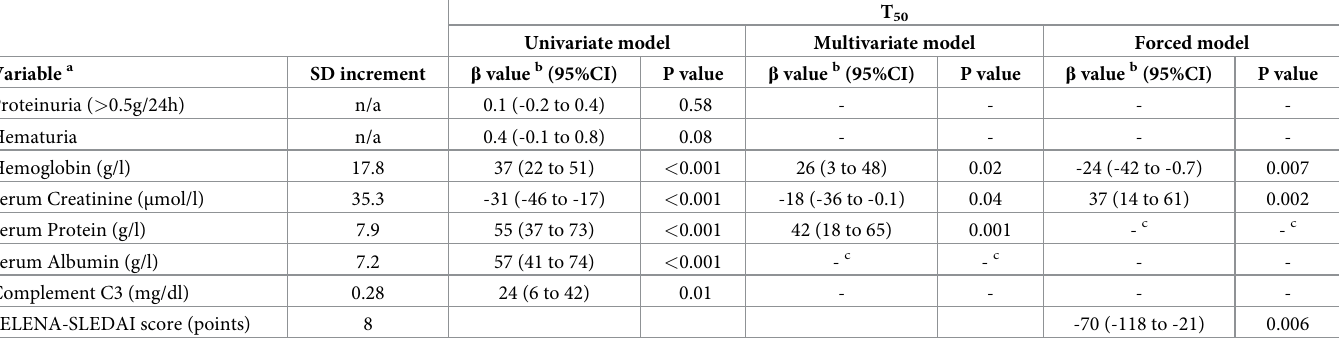
Table 2. Determinants of serum calcium propensity score (T 50 ) in univariate, multivariate linear regression analyses and in forced model using SELENA-SLEDAI